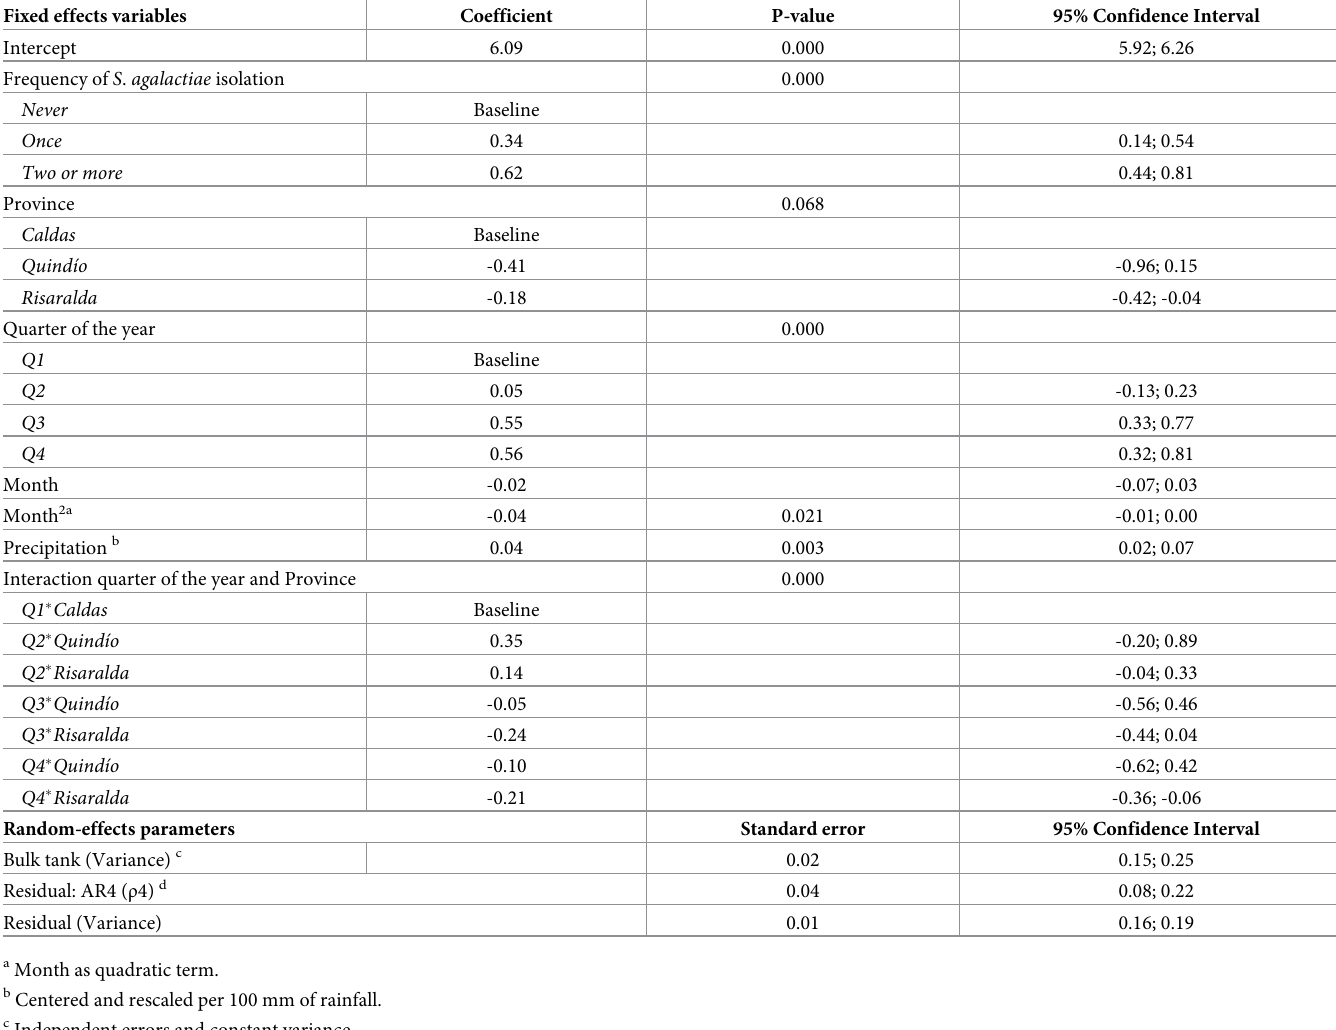
Table 3. Final linear mixed model of repeated measures of log-transformed bulk tank somatic cell count for herds in Colombian central western region (n = 152 herds). Fixed effects